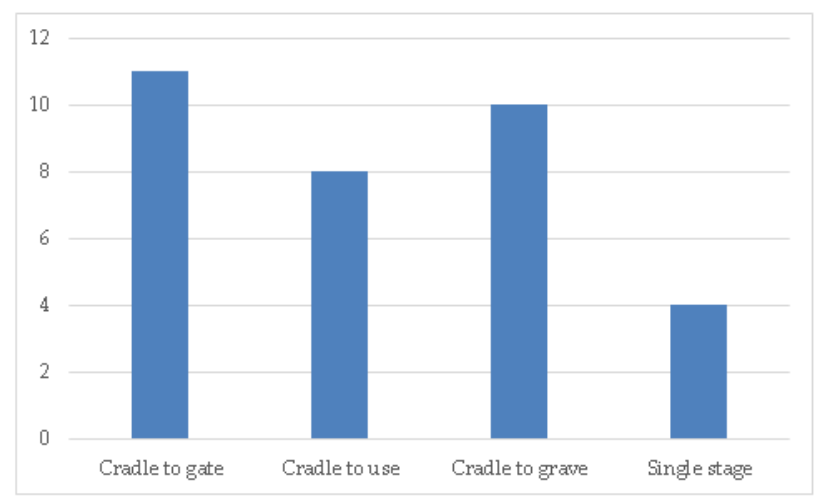
Figure 3. Number of works that used the same system boundaries.